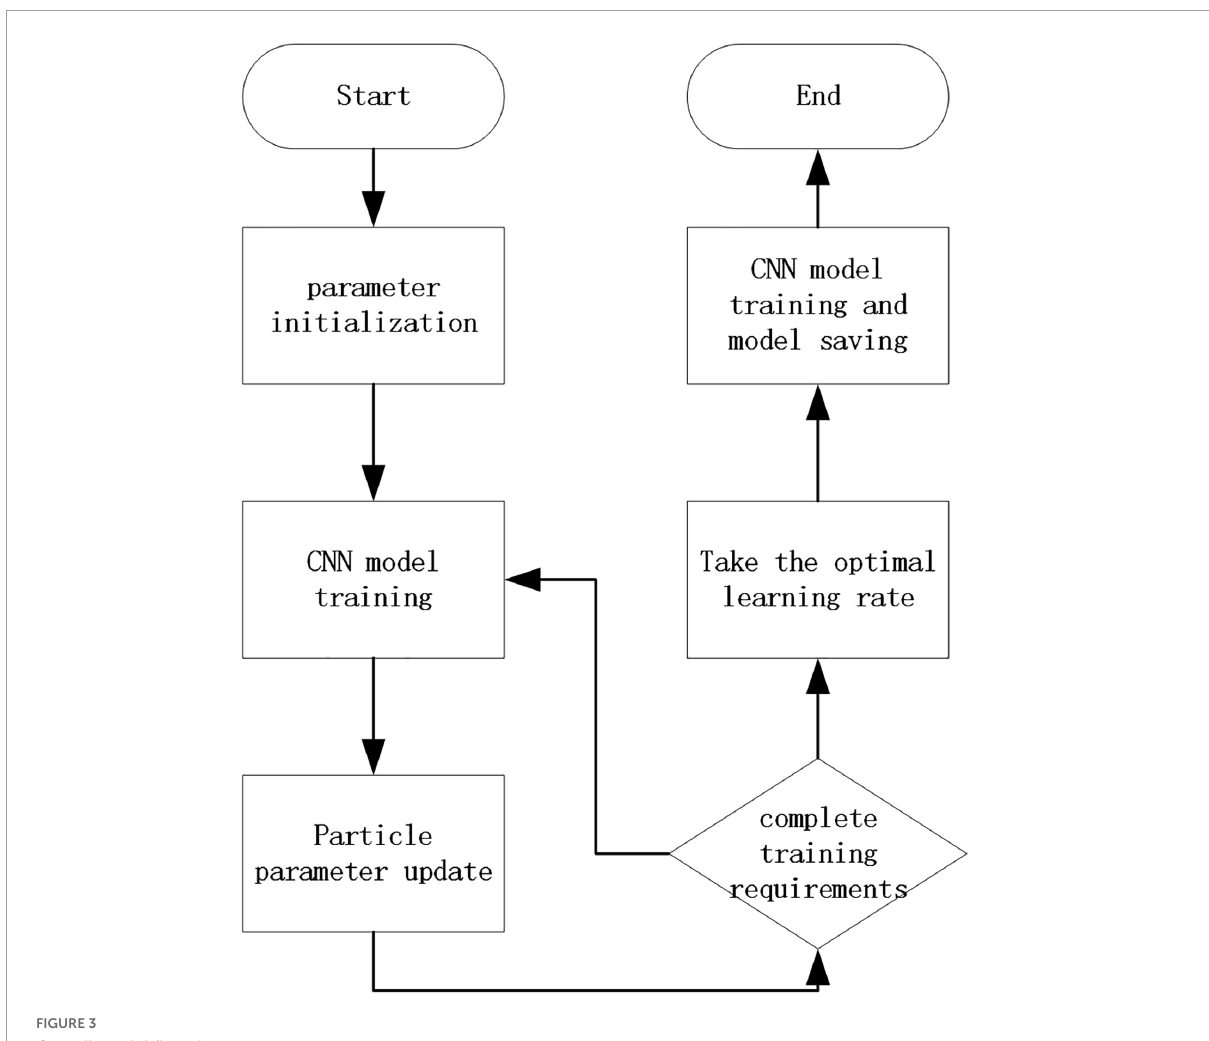
FIGURE3 Overall model flowchart.